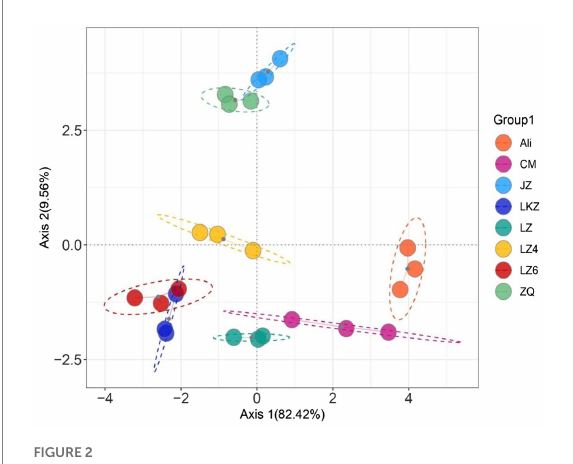
FIGURE 2 Principal component analysis (PCA) based on the seed properties of the highland barley varieties. CM, Cuomei; JZ, Jiangzi; LZ, Lazi; LZ4, Longzi4ling; LZ6, Longzi6ling; LKZ, Langkazi; and ZQ, Zangqing 2000.